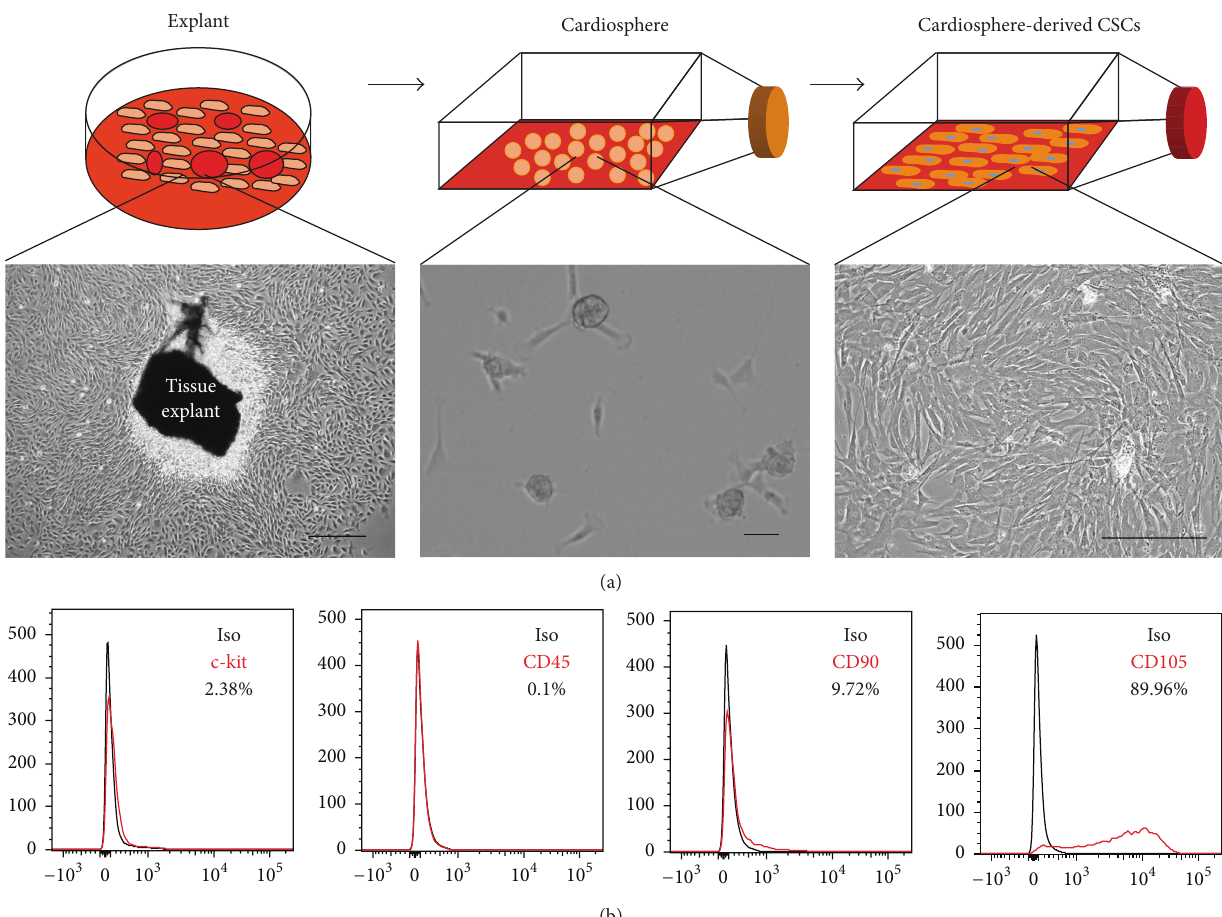
Figure 1: (a) Outline of the culture process going from heart biopsy, explants, cardiospheres, and finally CSCs. (b) Phase contrast images of cells at various stages of the culture process. Scale = 100 𝜇